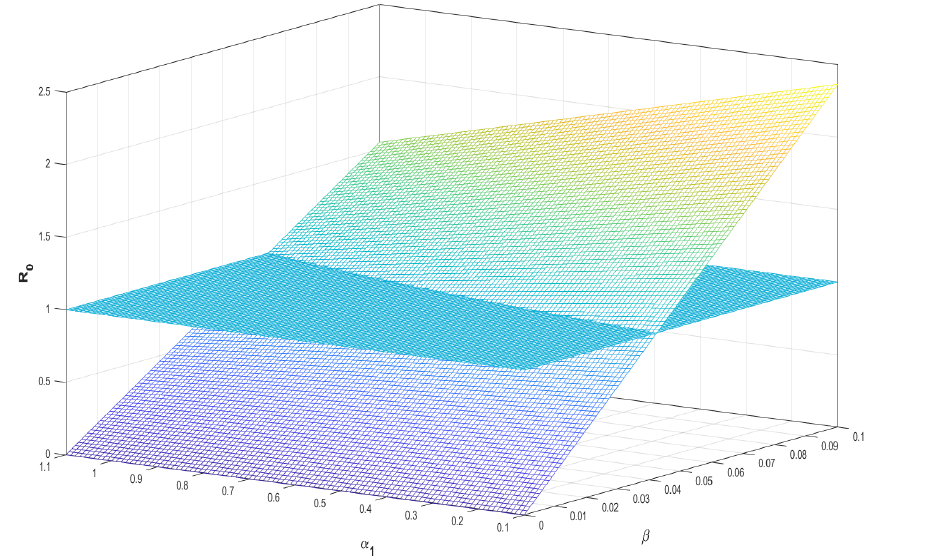
Figure 7. Shows a contour plot for the parameters α 1 and β